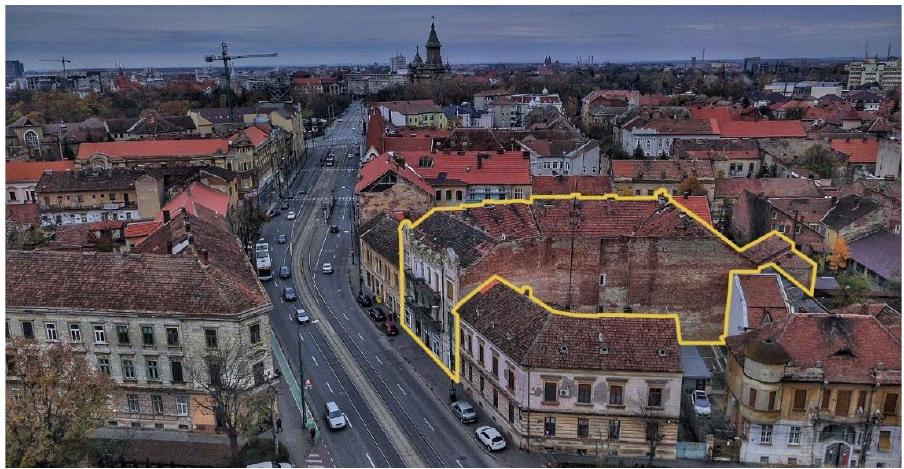
Figure 7. Aerial view over Timisoara, with the Lajos (Ludwig) Besch and Károly (Karl) Piffl Palace before restoration.